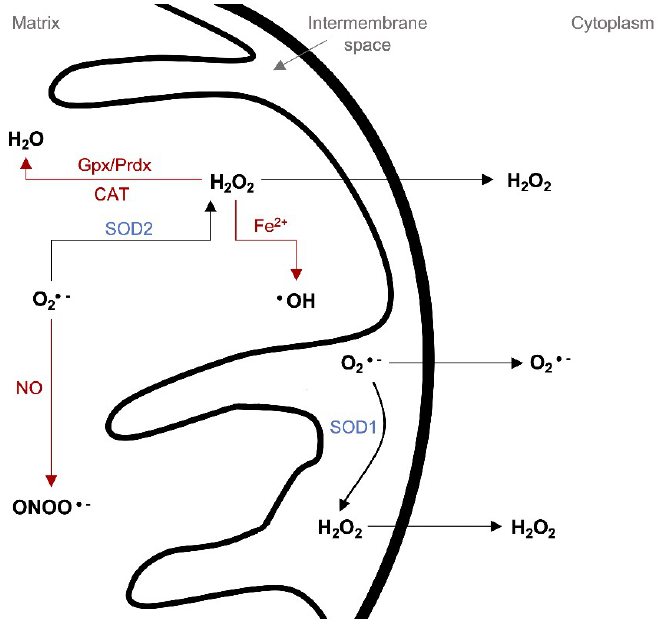
Figure 2. Schematic representation of reactive oxygen species (ROS) signaling in human mitochondria. Superoxide anion (O 2 •− ) emerges in the mitochondrial matrix and intermembrane space and can